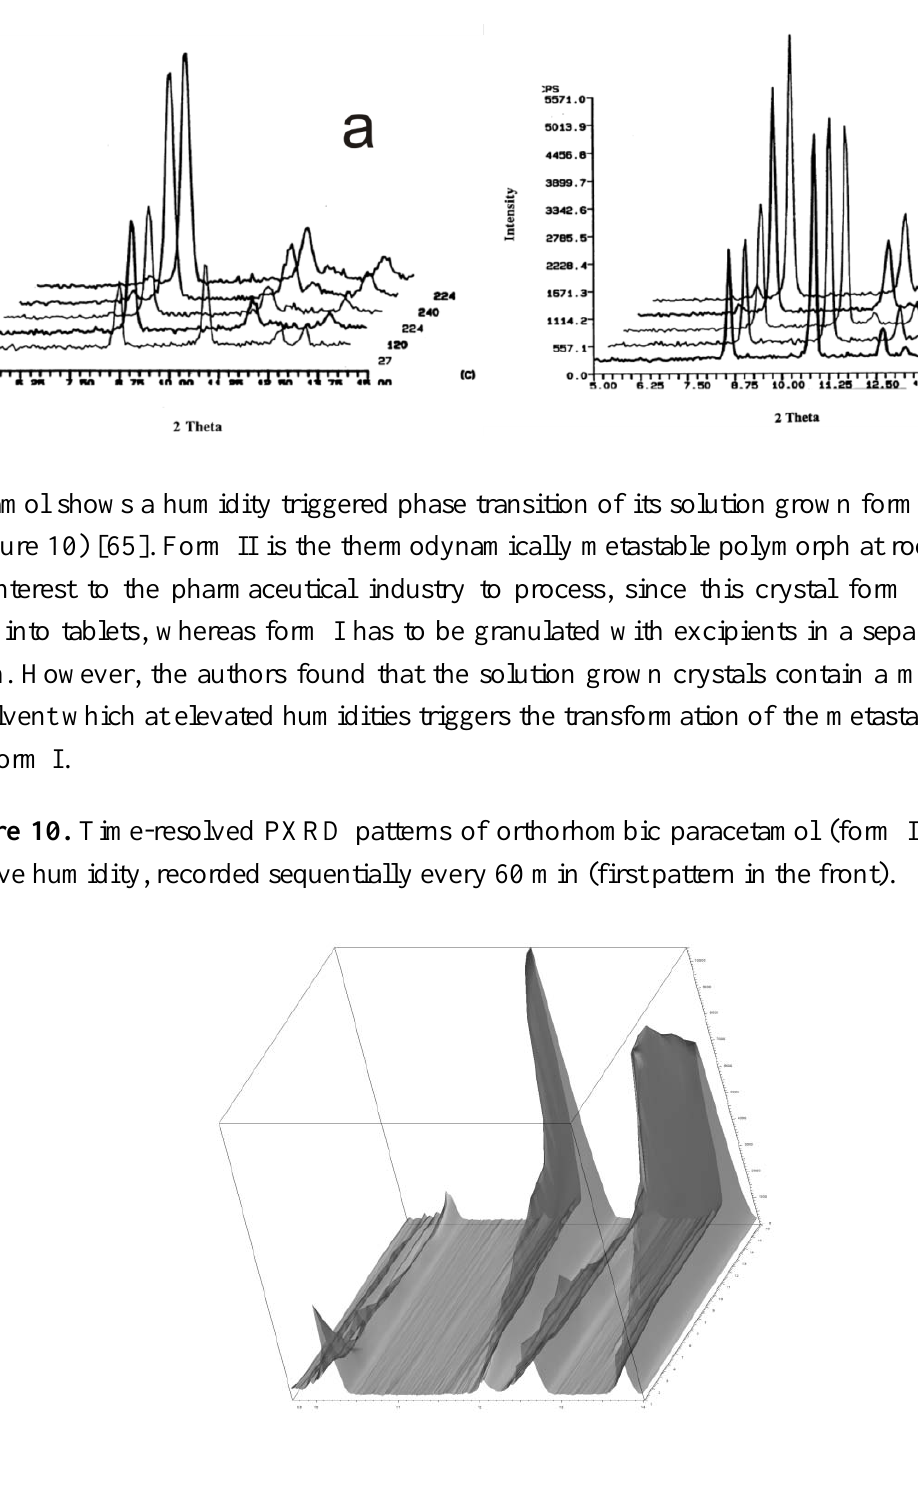
Figure 9. Nedocromil magnesium pentahydrate undergoing the complete transition to the dehydrated form while heated in (a) an open system and (b) a closed system (reprinted from [64], Copyright 2001, with permission from Elsevier).